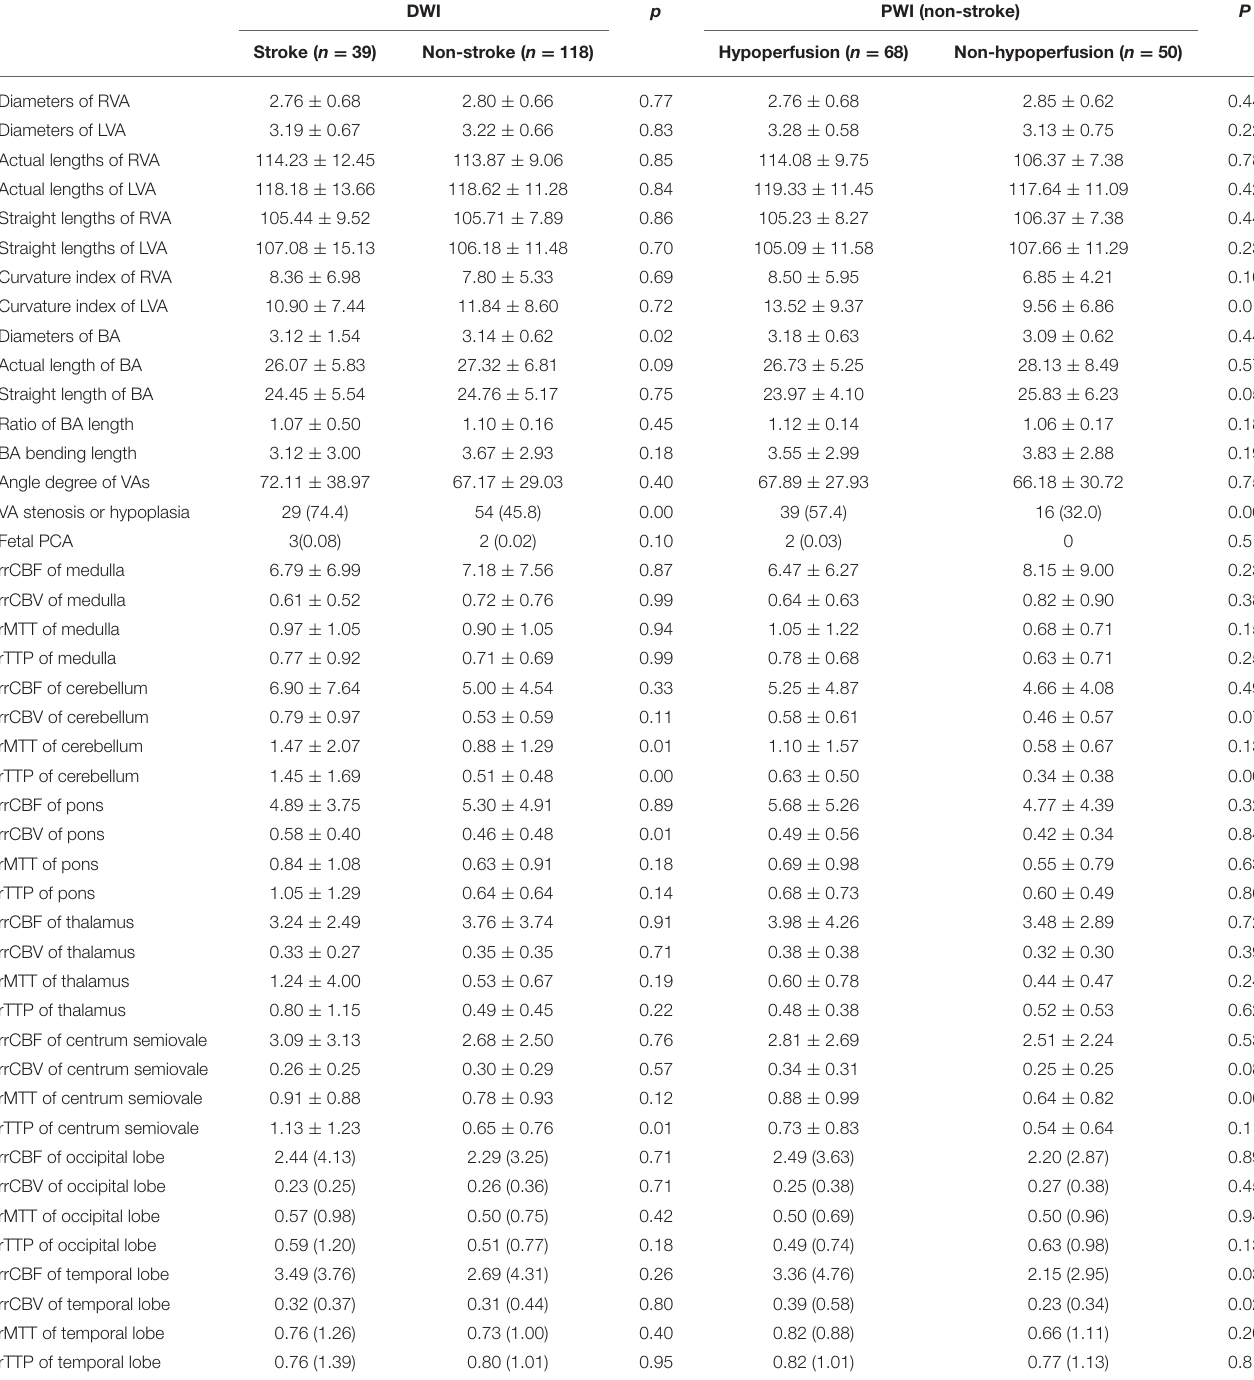
TABLE 3 | Risk factors for stroke and hypoperfusion on radiological imaging. DWI p PWI